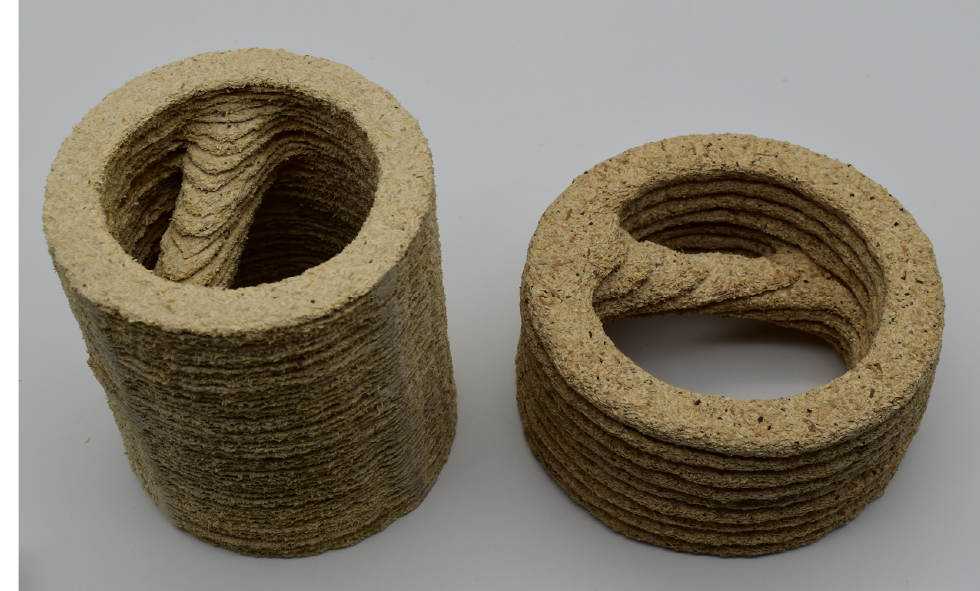
Figure 2. Demonstration objects for the ILF process with different panel thicknesses. While the panels were produced as described in the following sections, stacking and lamination were performed by hand with an epoxy resin as a